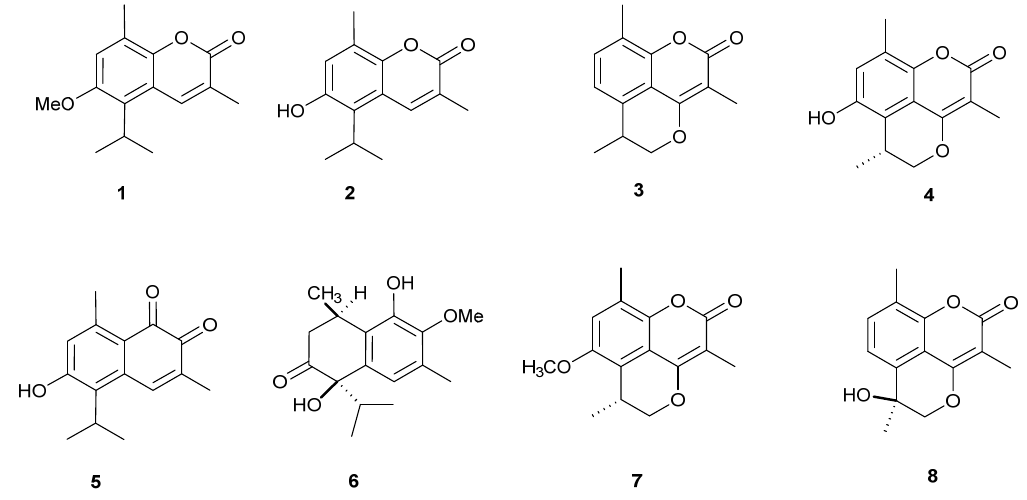
Figure 1. Compounds isolated from the heartwood of M. gagie Drumm.